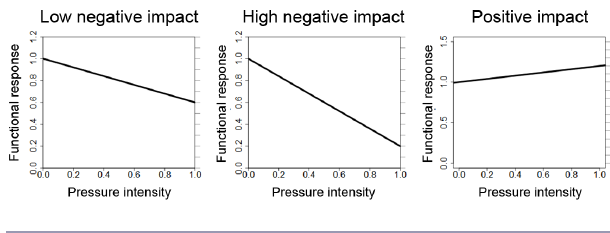
Fig. 4. Functional responses for low negative, high negative, and positive impacts used in the final version of the North Sea